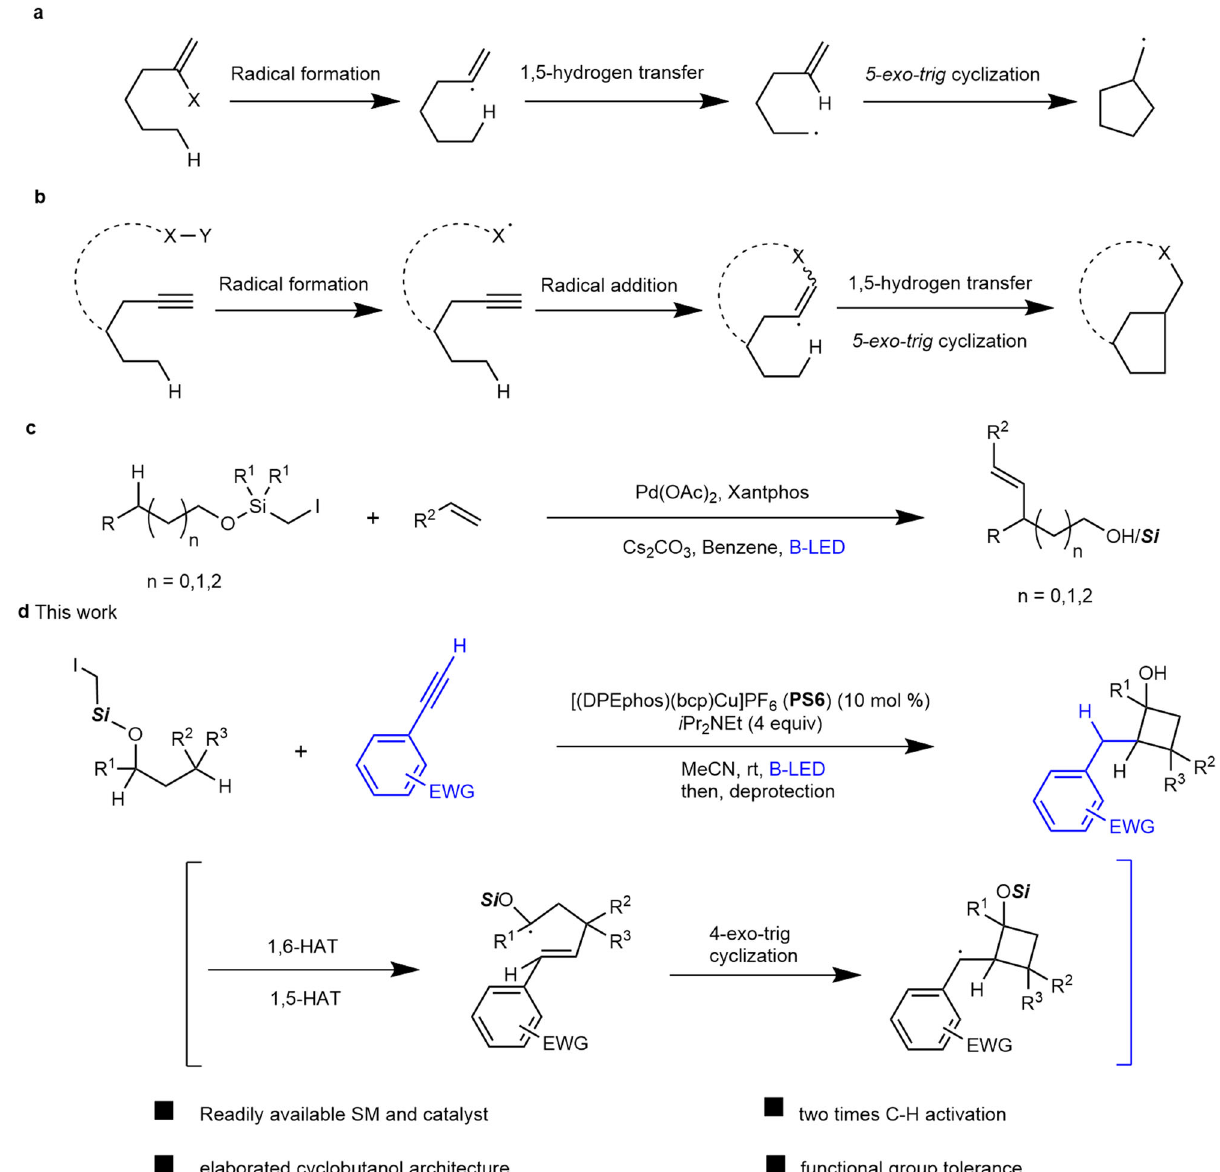
Fig. 1 Remote C − H functionalization via HAT. a Vinyl radical triggered by activation of C(sp 2 )-X initiated HAT and cyclization. b Vinyl radical triggered by radical addition to alkyne initiated HAT and cyclization. c Remote C − H functionalization via HAT enabled by an iodomethylsilyl auxiliary. d Photoinduced copper-catalyzed sequential 1,n-HAT enabling the formation of